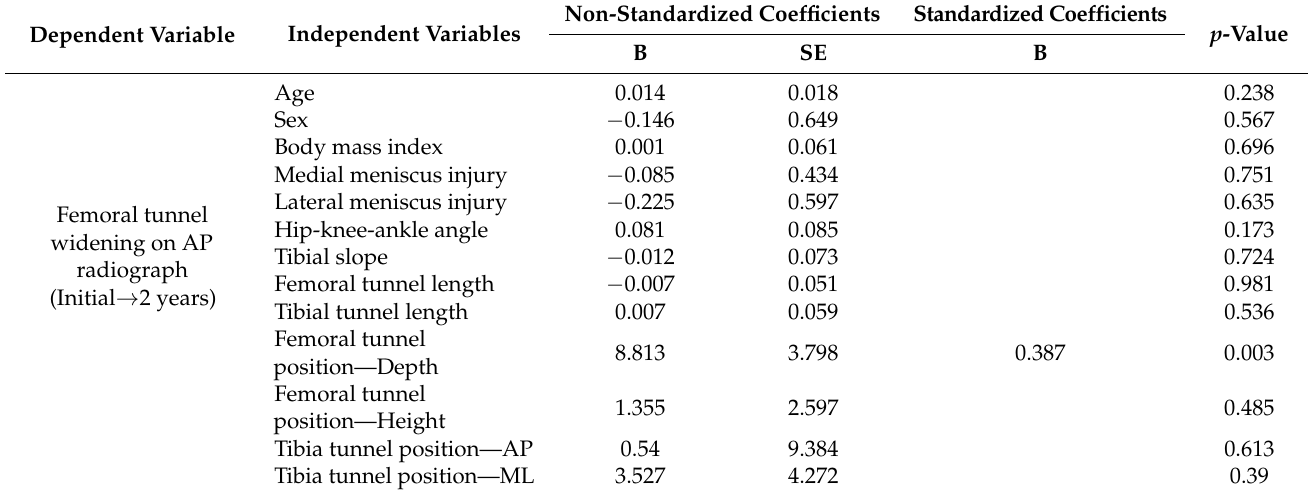
Table 6. Multiple regression analysis of potential predictive factors correlated with the femoral tunnel widening observed on the anteroposterior radiograph.